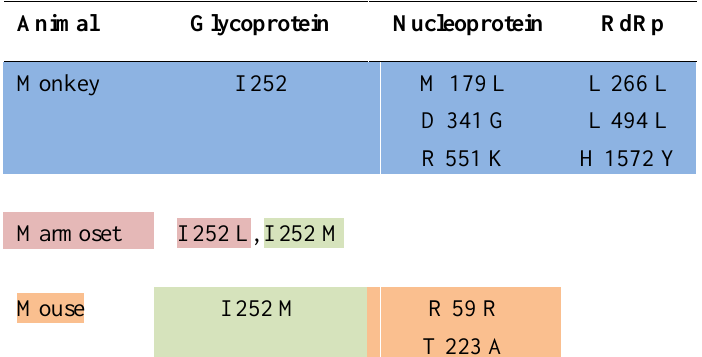
Table 2. Host-specific SNPs found after ML29 vaccination of different animals. Those specific mutations were found in rhesus macaque monkeys (Blue shade), marmosets (Pink shade), mouse (Orange shade) or common to marmoset and mouse (Green shade). Letters and numbers represent the amino acid change and the protein position. Those sites with the same amino acid represent synonymous changes.